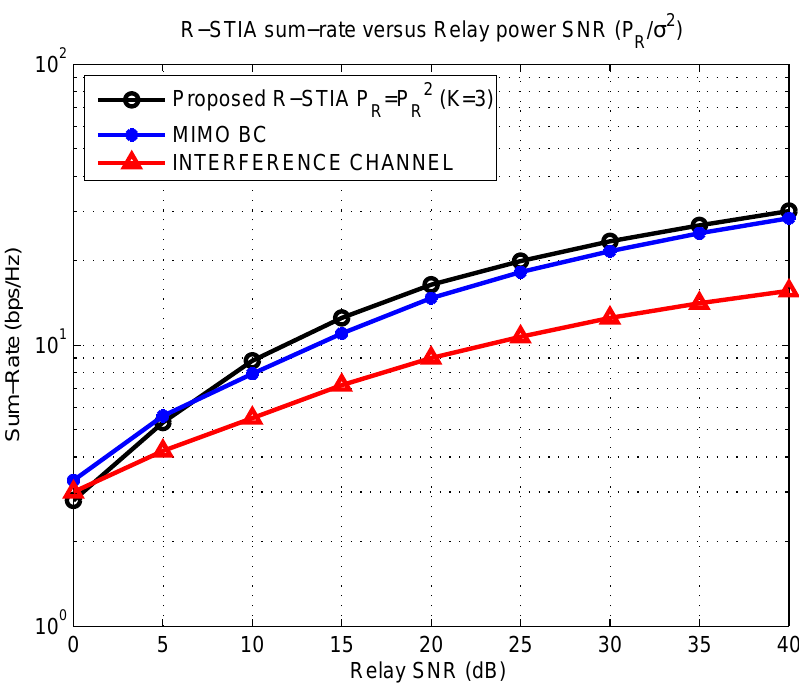
Figure 8. Sum-rate for the proposed relay space-time interference alignment (R-STIA) technique.